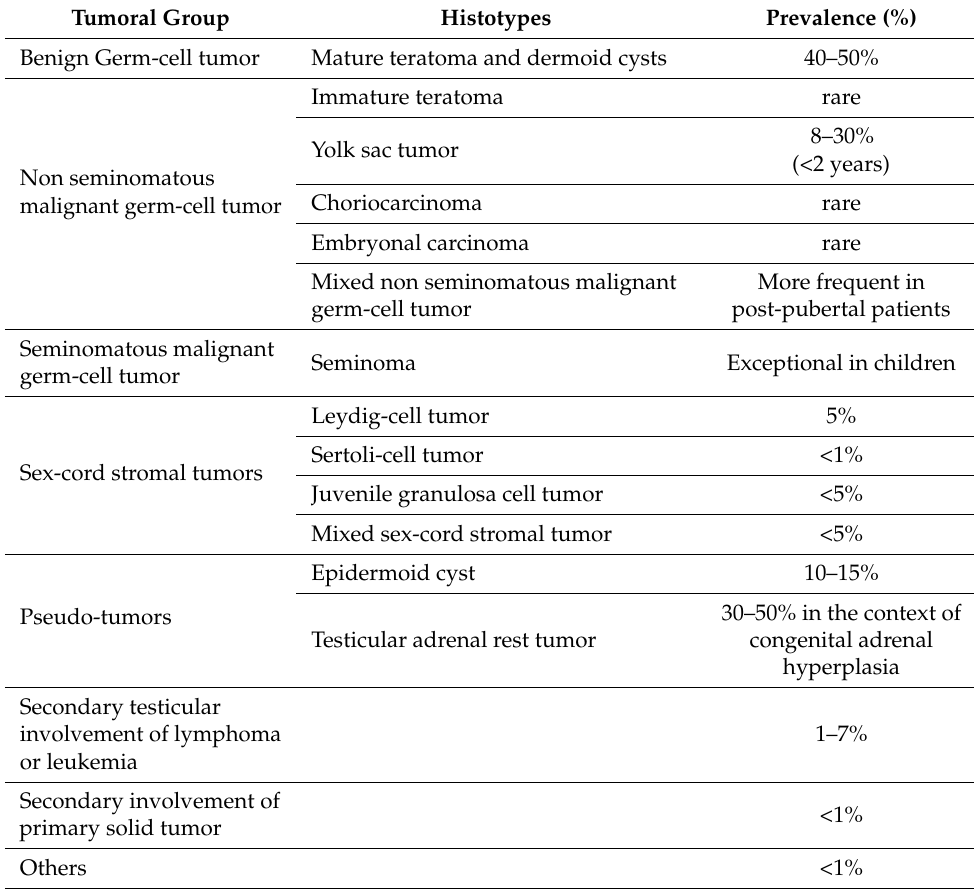
Table 1. Classification of intratesticular tumors in